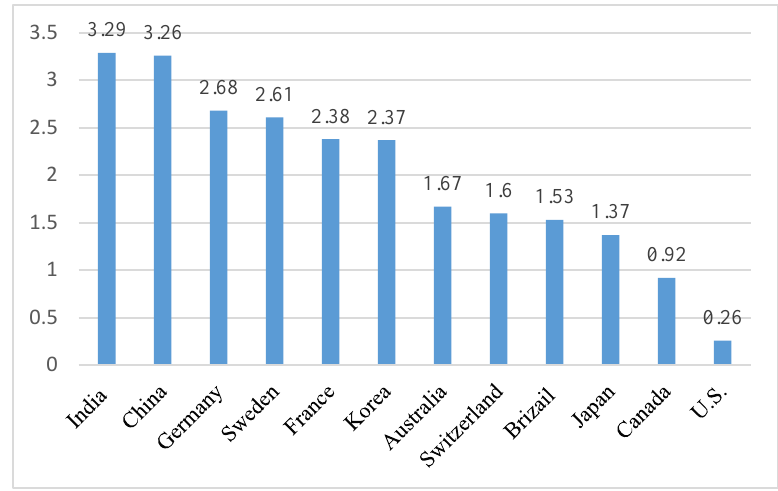
Figure 1. The OECD indicators of the strictness of employment protection-individual and collective dismissals in 2012 (regular contracts). Source: OECD. Indicators of the Strictness of Employment Protection—Individual and Collective Dismissals in 2012 (Regular Contracts). OECD: Paris, France, 2012. Available online: https: // stats.oecd.org / Index.aspx?DataSetCode = EPL_OV (accessed on 2 August 2018) [54].